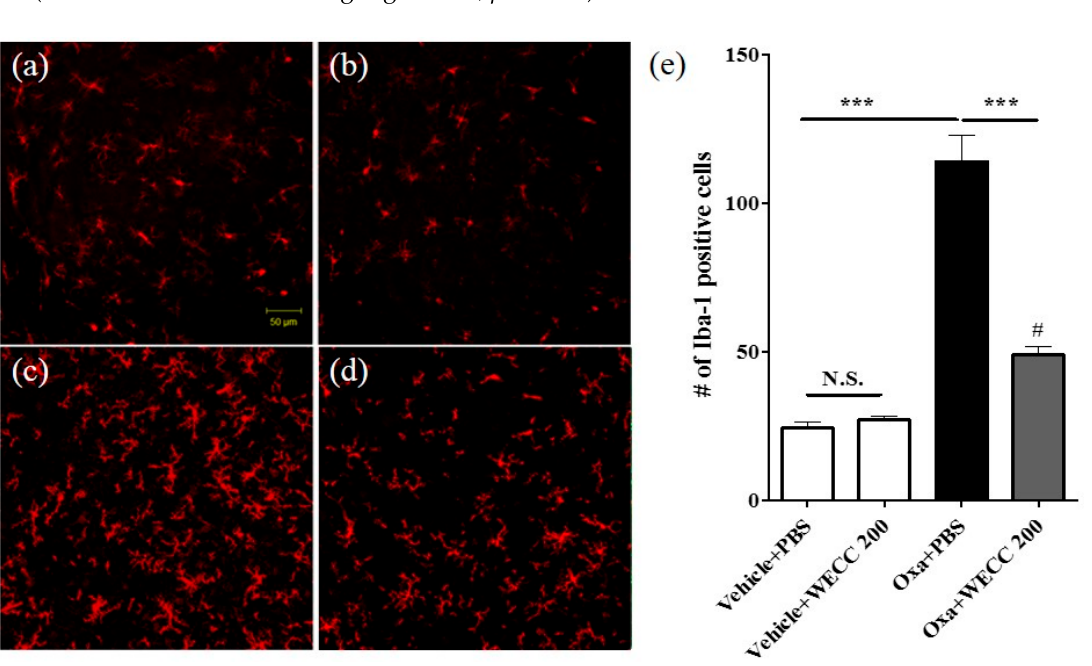
Figure 3. Immunohistochemical analyses of spinal microglia. Representative images of Iba-1 positive cells (microglia) in the spinal dorsal horn of Vehicle + PBS ( a ); Vehicle + 200 mg/kg WECC ( b ); Oxa + PBS ( c ); and Oxa + 200 mg/kg WECC ( d ) groups; ( e ) Quantification results of Iba-1 positive cells in the four groups. n = 6 per group. Data are presented as mean ± S.E.M. N.S.: non-significant; *** p < 0.001 vs. indicated group; # p < 0.05 vs. Vehicle + PBS by one-way ANOVA followed by Bonferroni’s post-test.